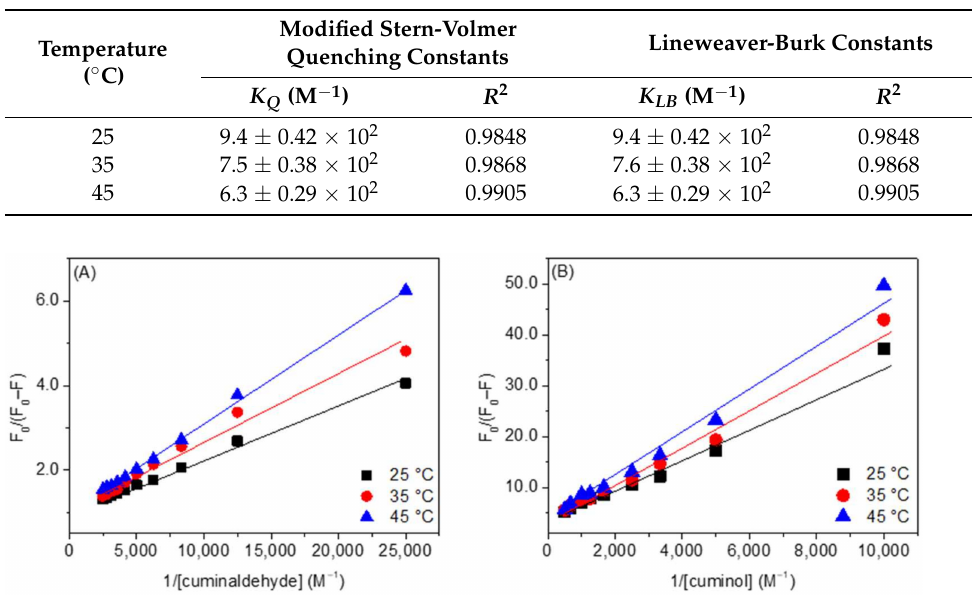
Figure 5. Modified Stern-Volmer plots of ( A ) HSA–cuminaldehyde and ( B ) HSA–cuminol systems at various